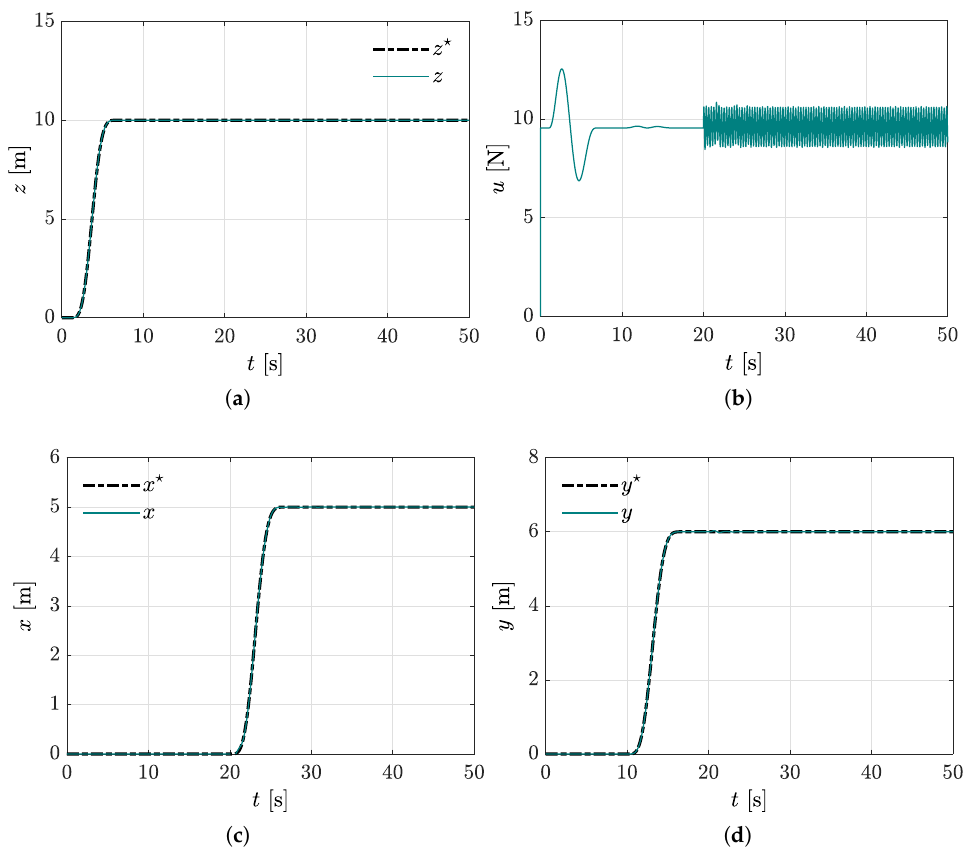
Figure 6. Controlled motion with disturbance inputs. ( a ) Controlled vertical position. ( b ) Main trust force control input u . ( c ) Controlled x position. ( d ) Controlled x